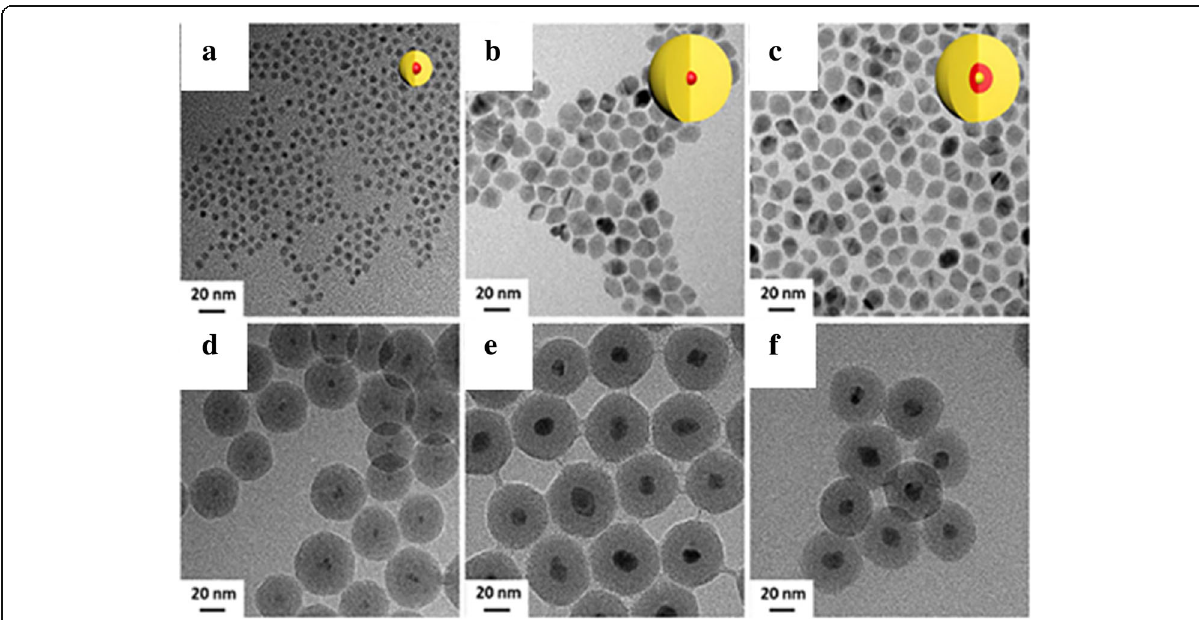
Fig. 13 TEM images of CdSe/CdS core/shell QDs with CdS thin shell ( a ) and after coating with silica CdSe/CdS@SiO 2 ( d ); CdSe/CdS core/ shell QDs with CdS shell ( b ) and after coating with silica CdSe/CdS@SiO 2 ( e ); CdS/CdSe/CdS core/shell QDs ( c ) and after coating with silica CdS/CdSe/CdS@SiO 2 ( f )